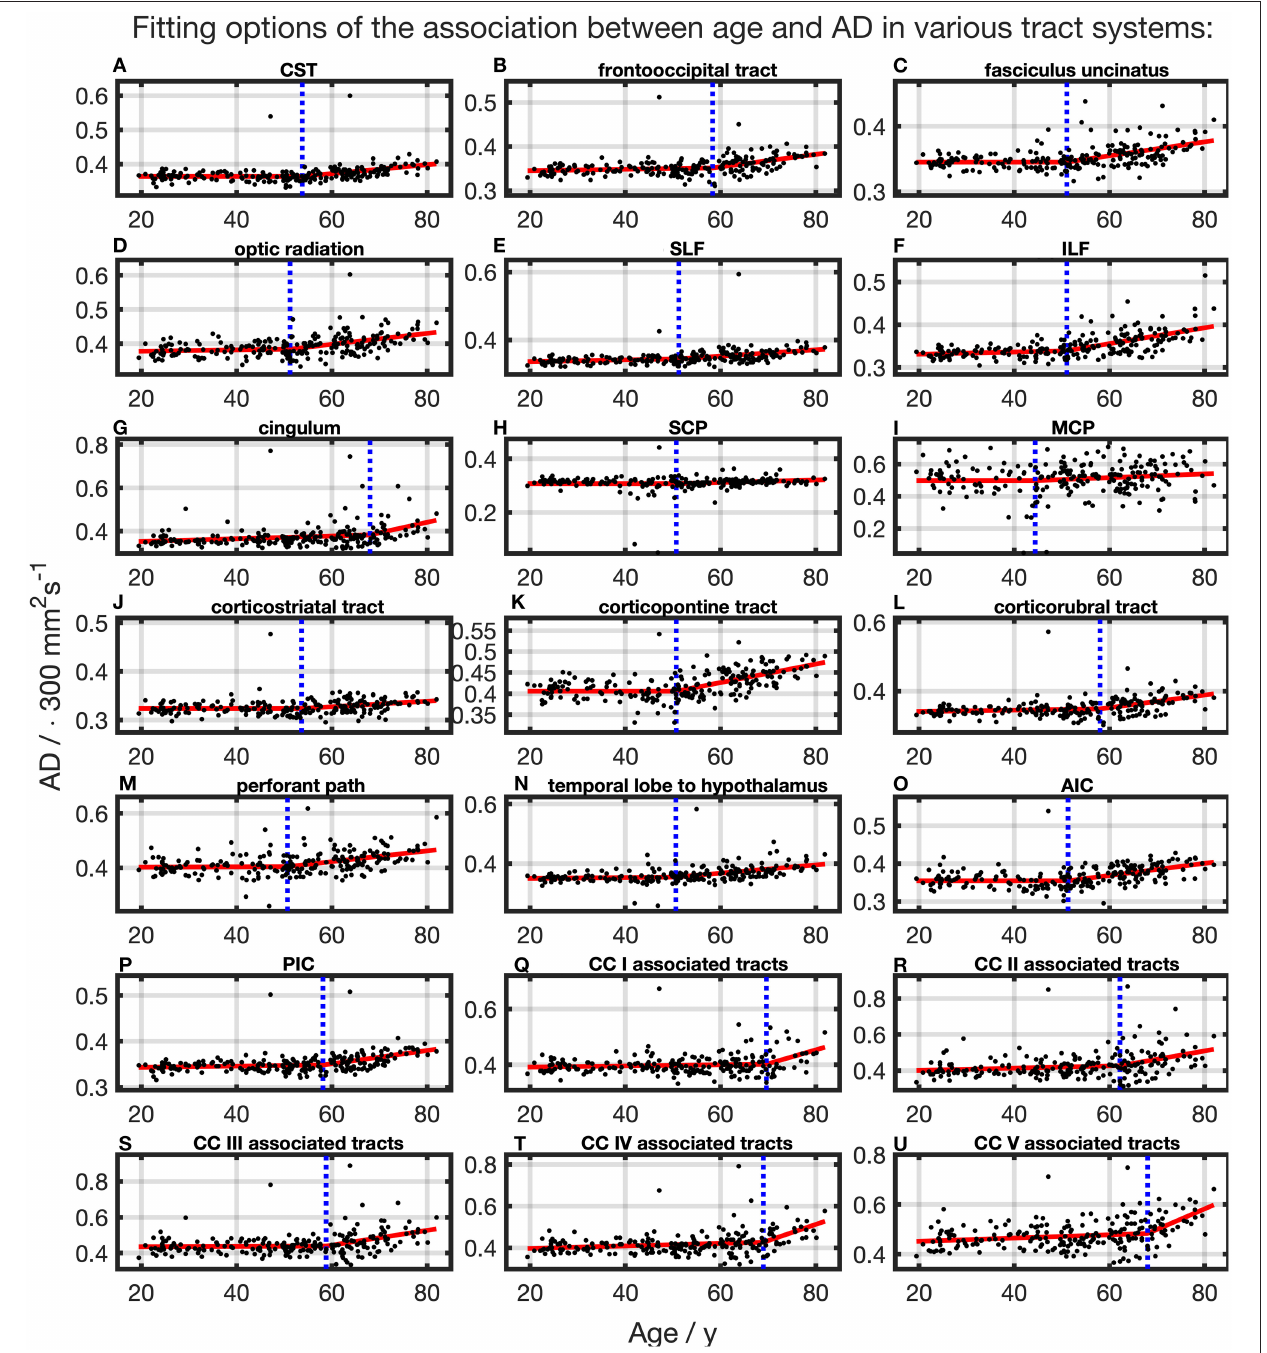
FIGURE 6 | Scatter plots (black) and regression line (red) of the association between age and AD in various tract systems. (A–U) All plots are fitted with a segmented linear regression due to a higher adjusted R 2 in comparison to a linear regression fit over the whole age span. The position of the knot between two linear curve segments is given as a blue dashed line (CC, corpus callosum; CST, corticospinal tract; SLF, superior longitudinal fasciculus; ILF, inferior longitudinal fasciculus; SCP, superior cerebellar peduncle; MCP, middle cerebellar peduncle; AIC, anterior limb of internal capsule; PIC, posterior limb of internal